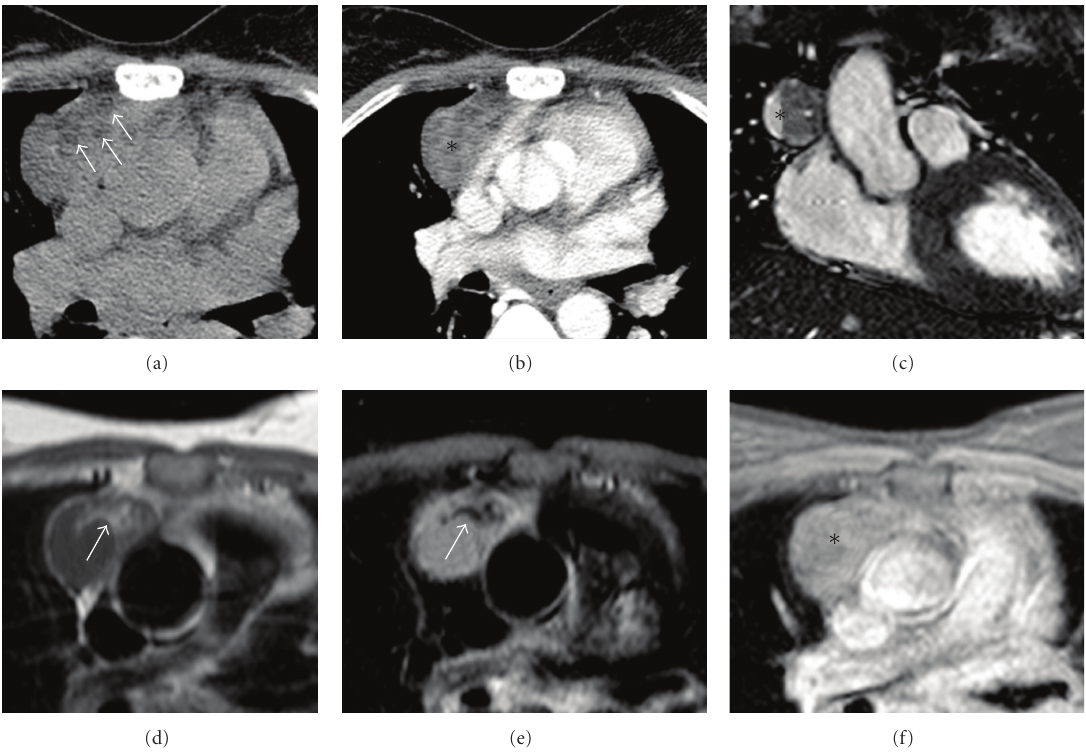
Figure 3: Teratoma. A well-circumscribed solid mass is present adjacent to the right atrial appendage ((b), (c), (f) asterisk). Foci of low attenuation are identified within it on noncontrast axial MDCT ((a), white arrows). Similar areas can be seen on the T1-weighted image ((d), white arrow) and show signal “dropout” with a fat-suppressed sequence ((e), white arrow). The presence of fat in a mixed density mediastinal lesion raised the possibility of teratoma, and this diagnosis was confirmed at